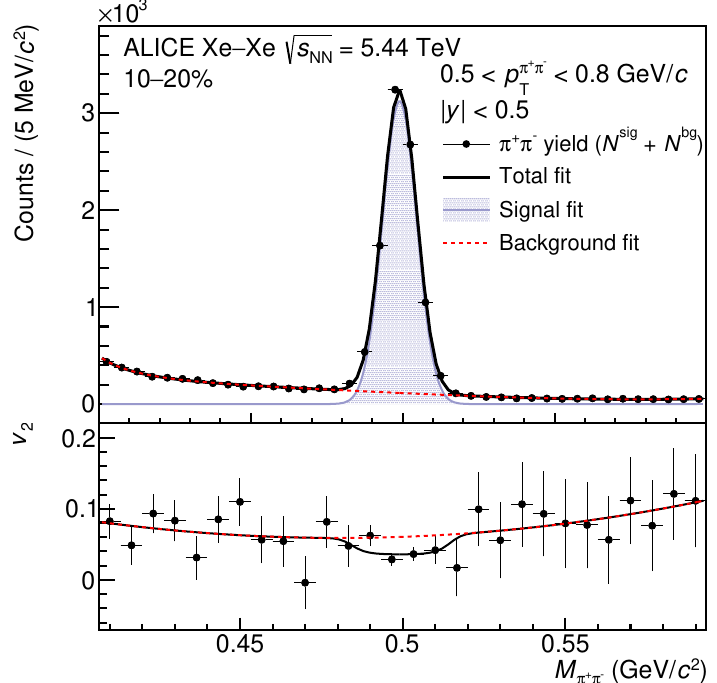
Figure 1. Top panel: invariant mass distribution of opposite-sign pion pairs belonging to candidate K 0 in the centrality range 10–20% and p T interval 0 . 5 < p π + π − S eq. (2.3) to the mass-dependent v 2